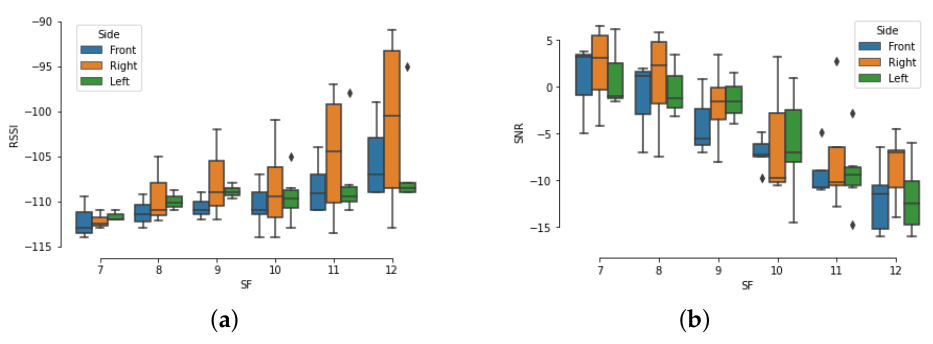
Figure 30. Average RSSI and SNR per SF LoRaWAN. ( a ) RSSI. ( b )